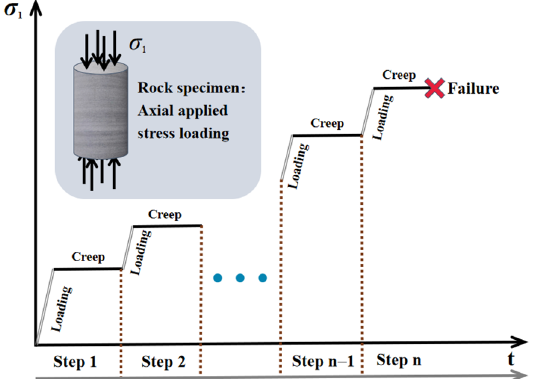
Figure 3. Schematic of multilevel-unconfined loading path.